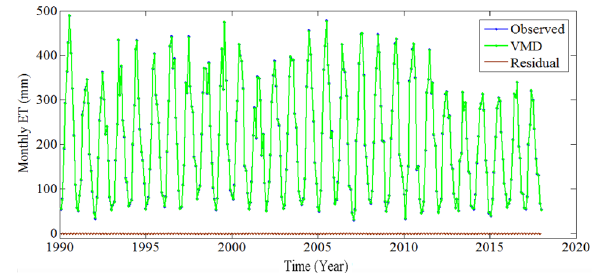
Figure 5. The results of VMD.